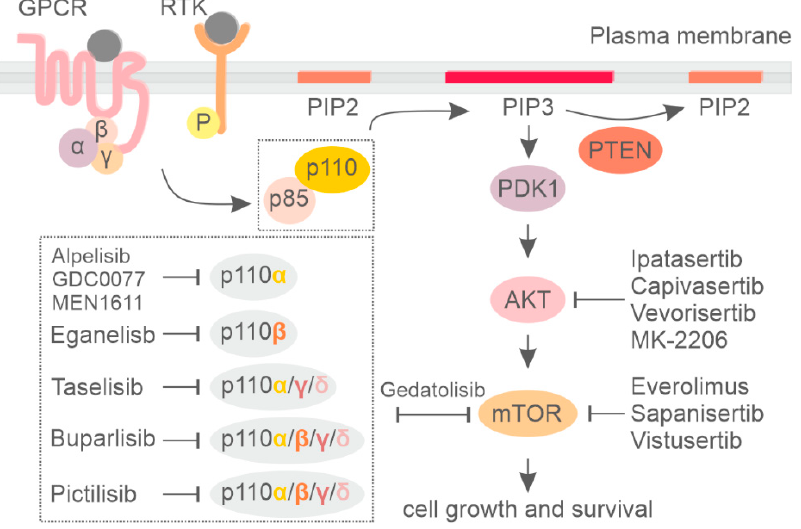
Figure 1. Signaling by the phosphatidylinositol-3-kinase (PI3K)/AKT/mammalian target of the rapamycin (mTOR) pathway and the respective inhibitors.